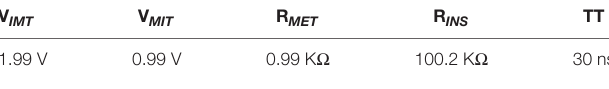
TABLE 1 | Vanadium dioxide (VO 2 ) electrical